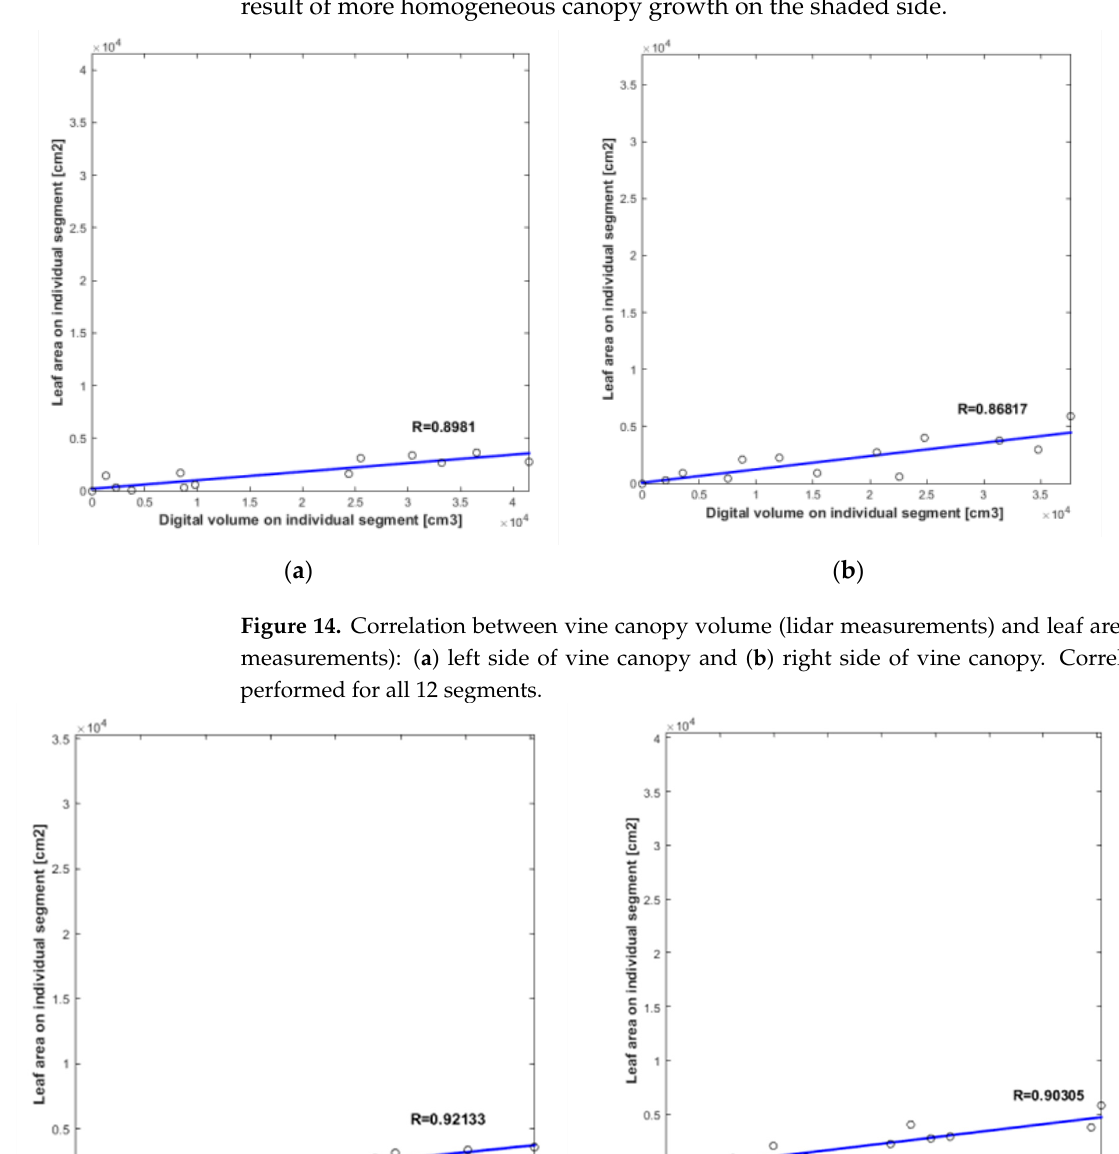
( b ) Figure 16. Correlation between the number of points (photogrammetric measurements) and the number of points (lidar measurements): ( a ) left side of canopy and ( b ) right side of canopy. The correlation was performed for all 12 segments .